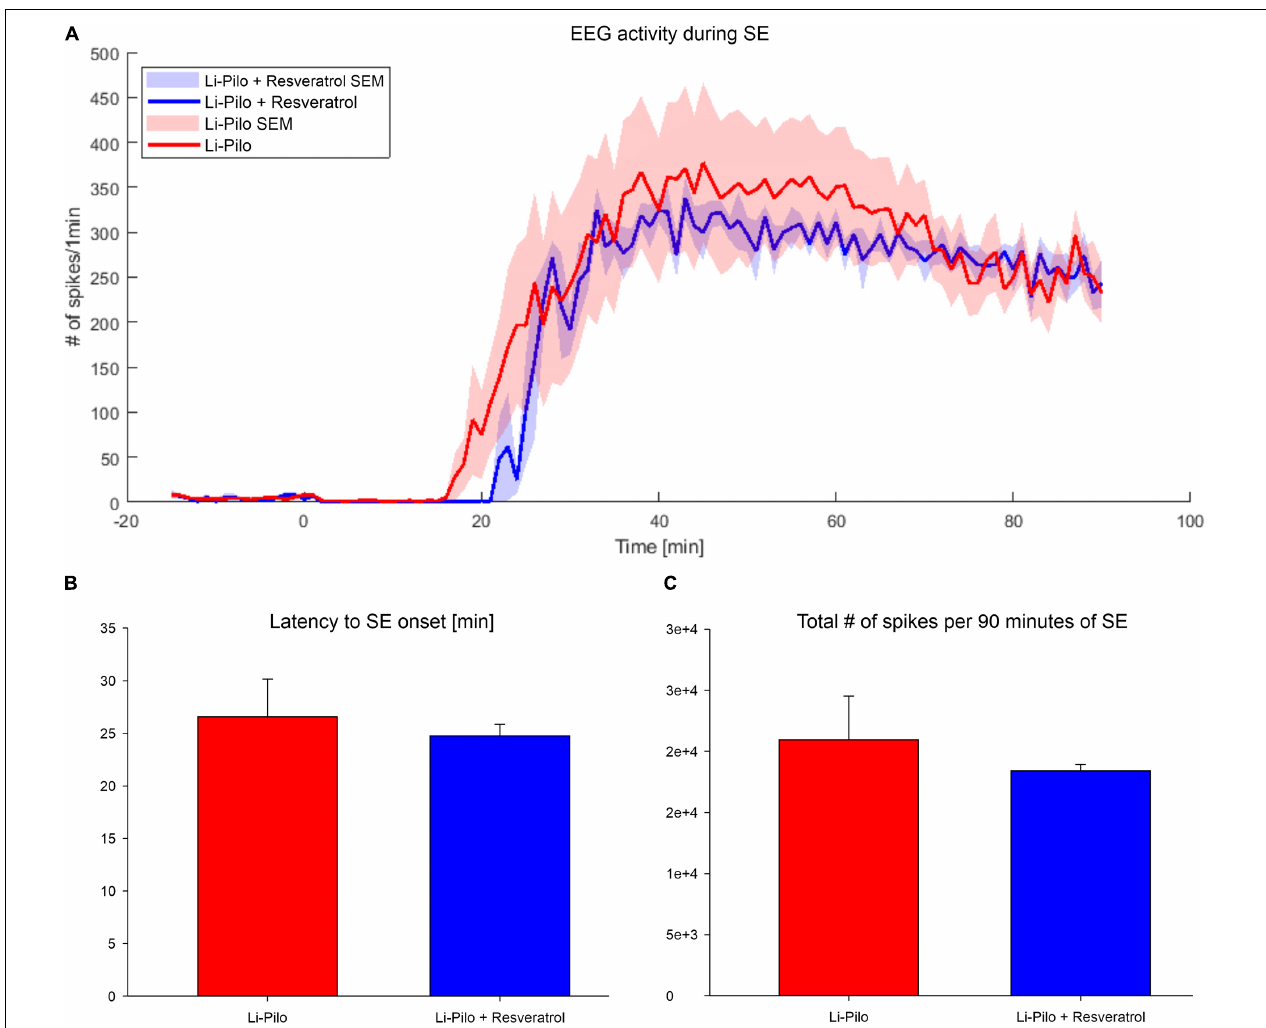
FIGURE 2 | (A) EEG activity during Li-Pilo status epilepticus has been determined as number of epileptic spikes in 60 s bins. Time zero is the time of pilocarpine application. Red line, convulsant agent alone; Blue line, convulsant agent plus resveratrol. (B) Latency to the first electrographic seizure does not differ after resveratrol treatment ( P = 0.753). Red column, convulsant agent alone; Blue column, convulsant agent plus resveratrol. (C) Total number of detected epileptic spikes during 90 min of SE duration was not influenced by resveratrol suggesting no anticonvulsant effect ( P = 0.668). Red column, convulsant agent alone; Blue column, convulsant agent plus